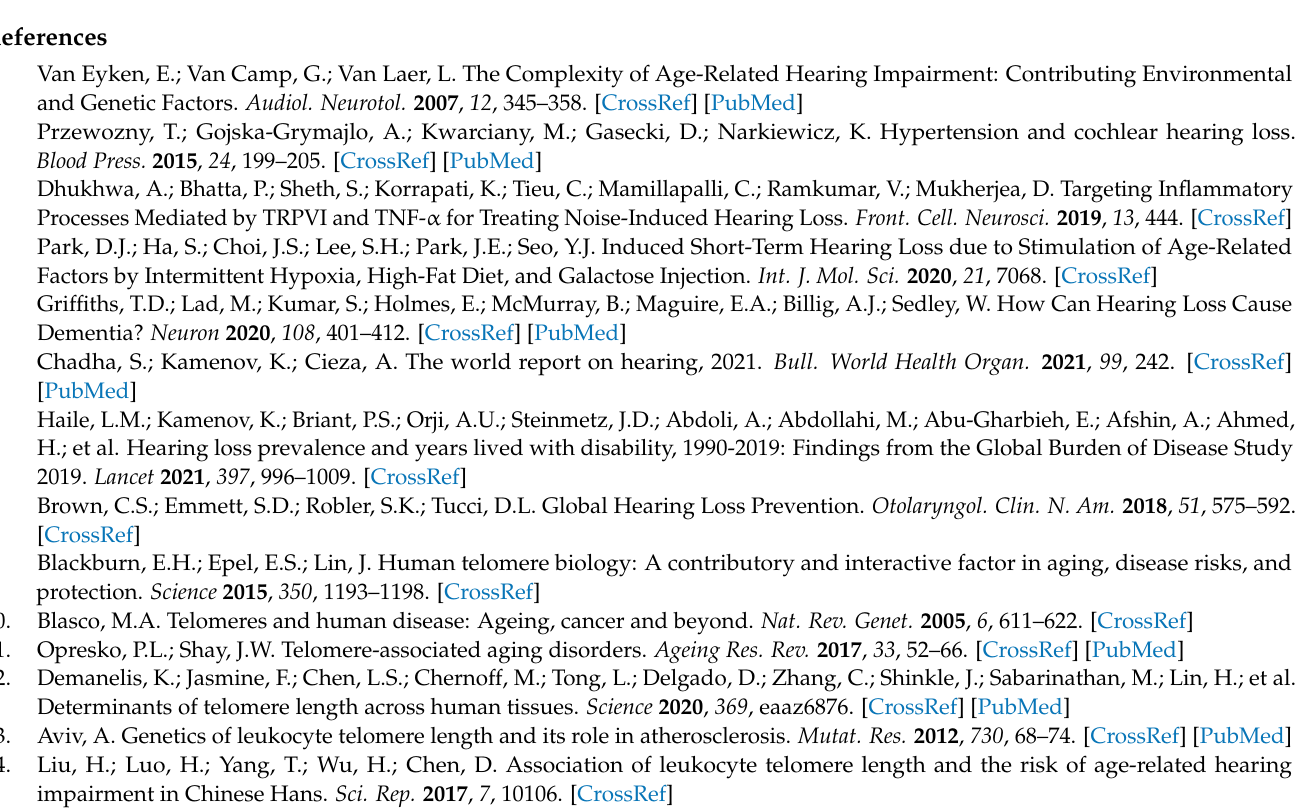
Supplementary Figure S3. “Leave-one-out” evaluation of the Mendelian randomization analyses of the associations between leukocyte telomere length and various hearing loss (HL) types. A, HL; B, age-related HL; C, noise-induced HL (NIHL); D, NIHL excluding heterogeneous sites rs2736176, rs3219104, rs8105767, and rs2302588. Supplementary Figure S4. Flow chart about the analytical methods and process of two-sample MR analysis. Supplementary Table S1. SNPs used for the LTL instruments in the Mendelian Randomization analyses. Table S2. The genetic instruments for Mendelian randomization analysis of leukocyte telomere length (exposure) and HL (outcome). Table S3. The genetic instruments for Mendelian randomization analysis of leukocyte telomere length (exposure) and ARHL (outcome). Table S4. The genetic instruments for Mendelian randomization analysis of leukocyte telomere length (exposure) and NIHL